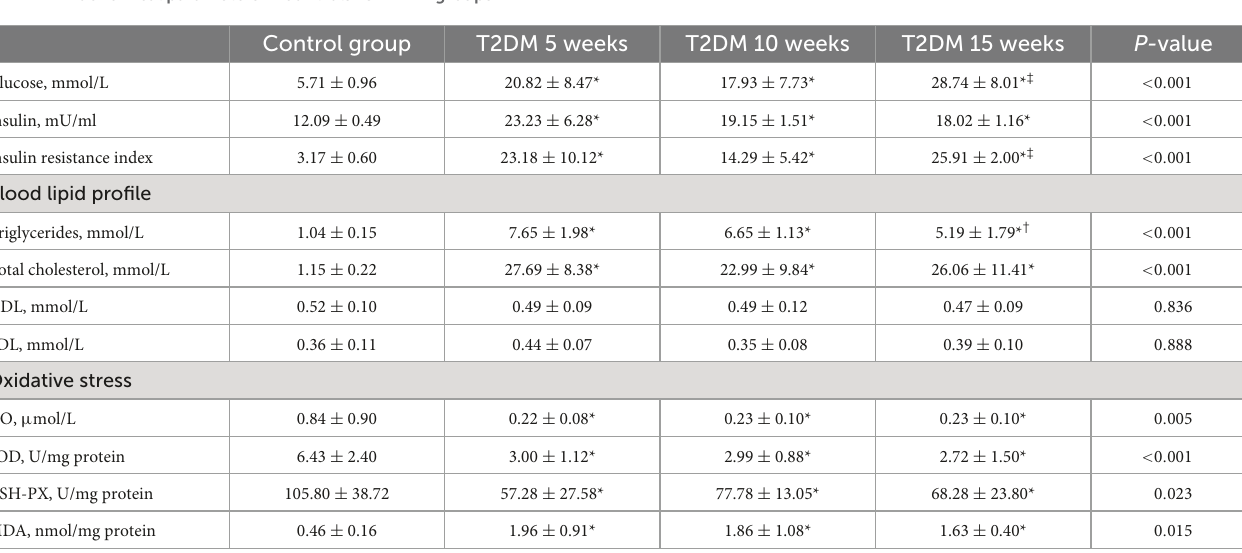
TABLE 1 Biochemical parameters in controls vs. T2DM